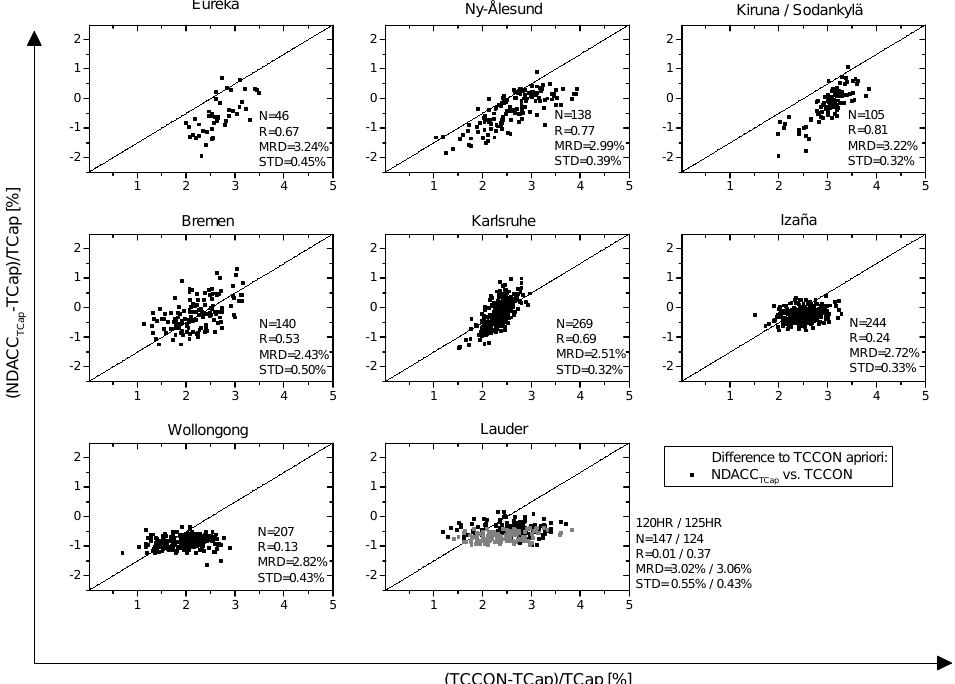
Figure B1. Correlation between (NDACC TCap -TCap) and (TCCON-TCap). The black line represents the one-to-one correlation shifted by 2.5%. The grey squares in the Lauder graph represent the data measured with the 125HR instrument, whereas the black squares are the data measured with the 120HR instrument.